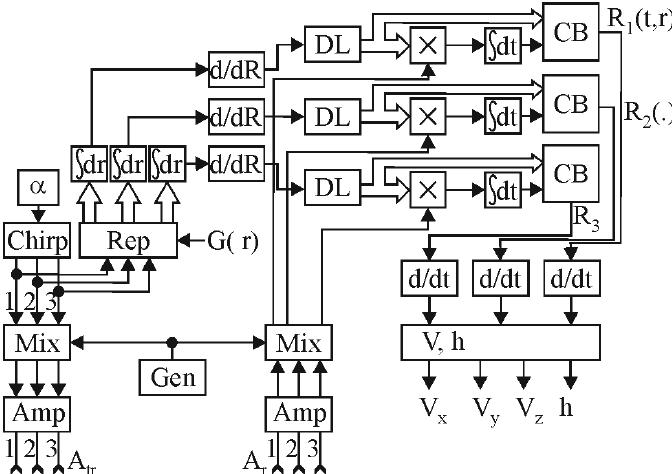
Figure 17. Estimates of the velocity vector components while a helicopter is landing.